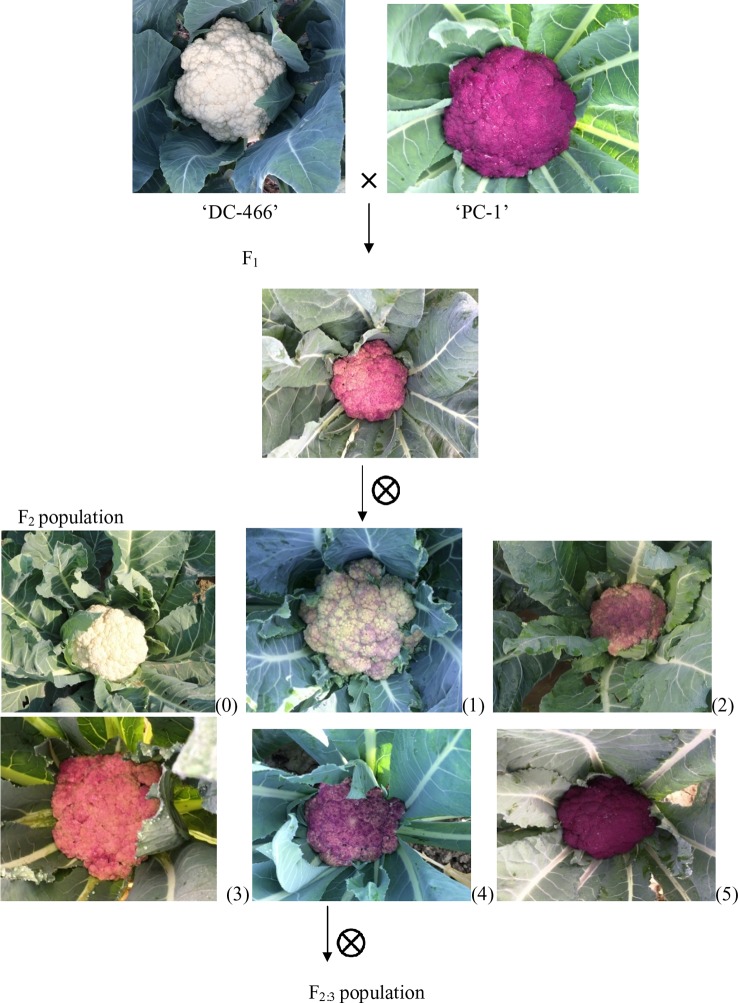
Observed curd color phenotypes of parents, F1, and F2 population. Curd color scale of ‘0–5'; 0 = white, 1–4 = light to intermediate purple; 5 = intense purple.